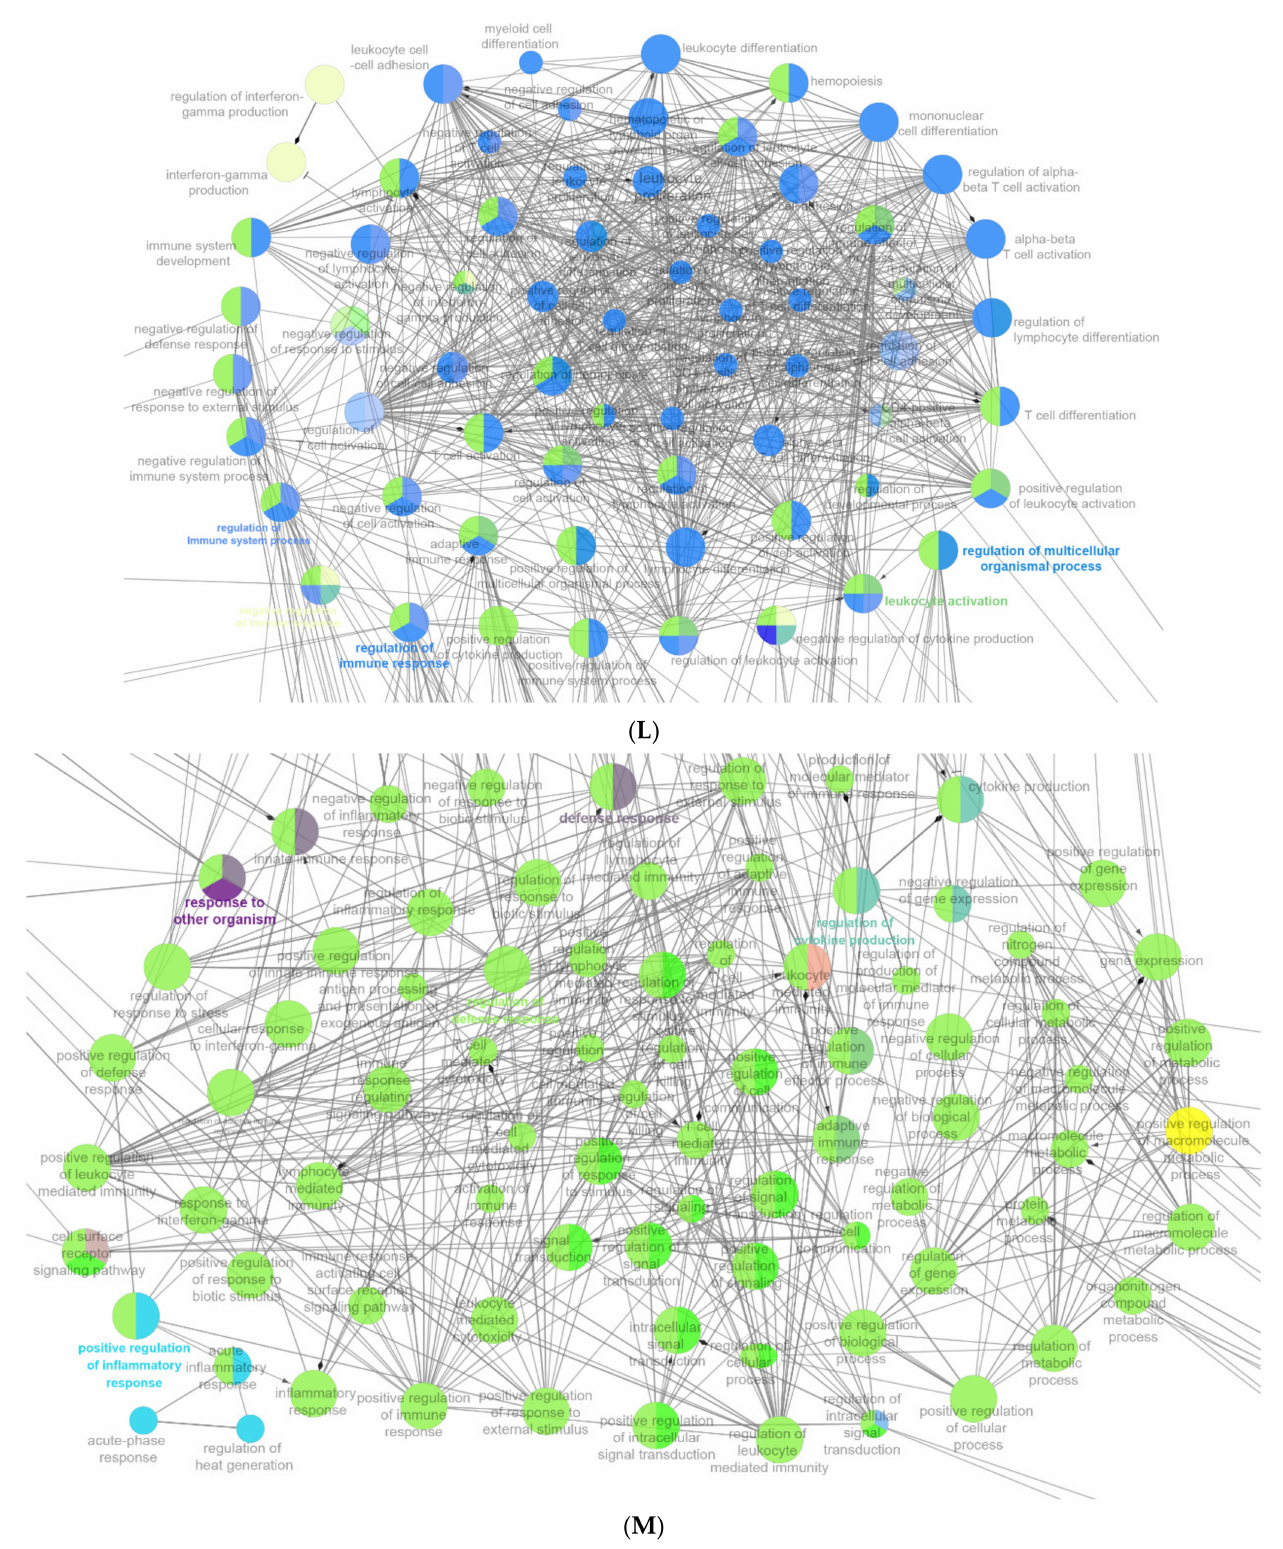
Figure 7. The enrichment analysis results of DEGs by using ClueGO. ( A ) Enriched biological pathways of down-regulated DEGs in group 1 (LPS vs. Control), including system development, organonitrogen compound metabolic process, negative regulation of chondrocyte differentiation, cell–cell signaling, cellular catabolic process, pattern specification process, cell surface receptor signaling pathway, regulation of cellular process, mesenchymal cell proliferation, and mesenchymal